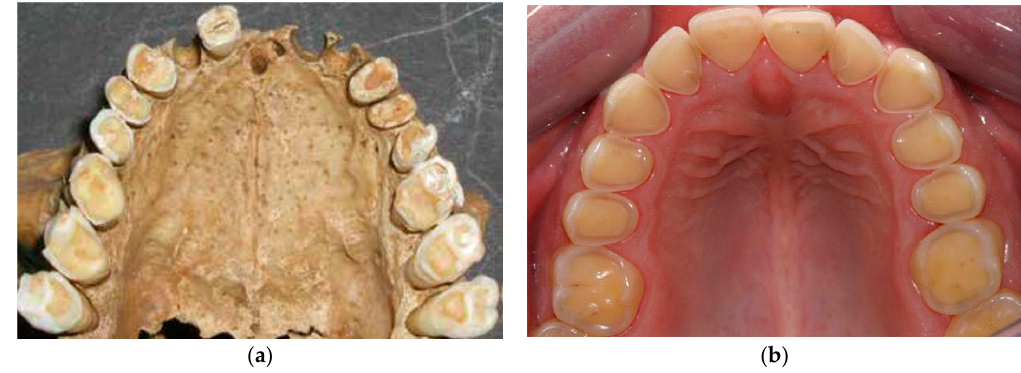
Figure 7. Similar characteristics ( a ) as seen in erosion in young people today ( b ).